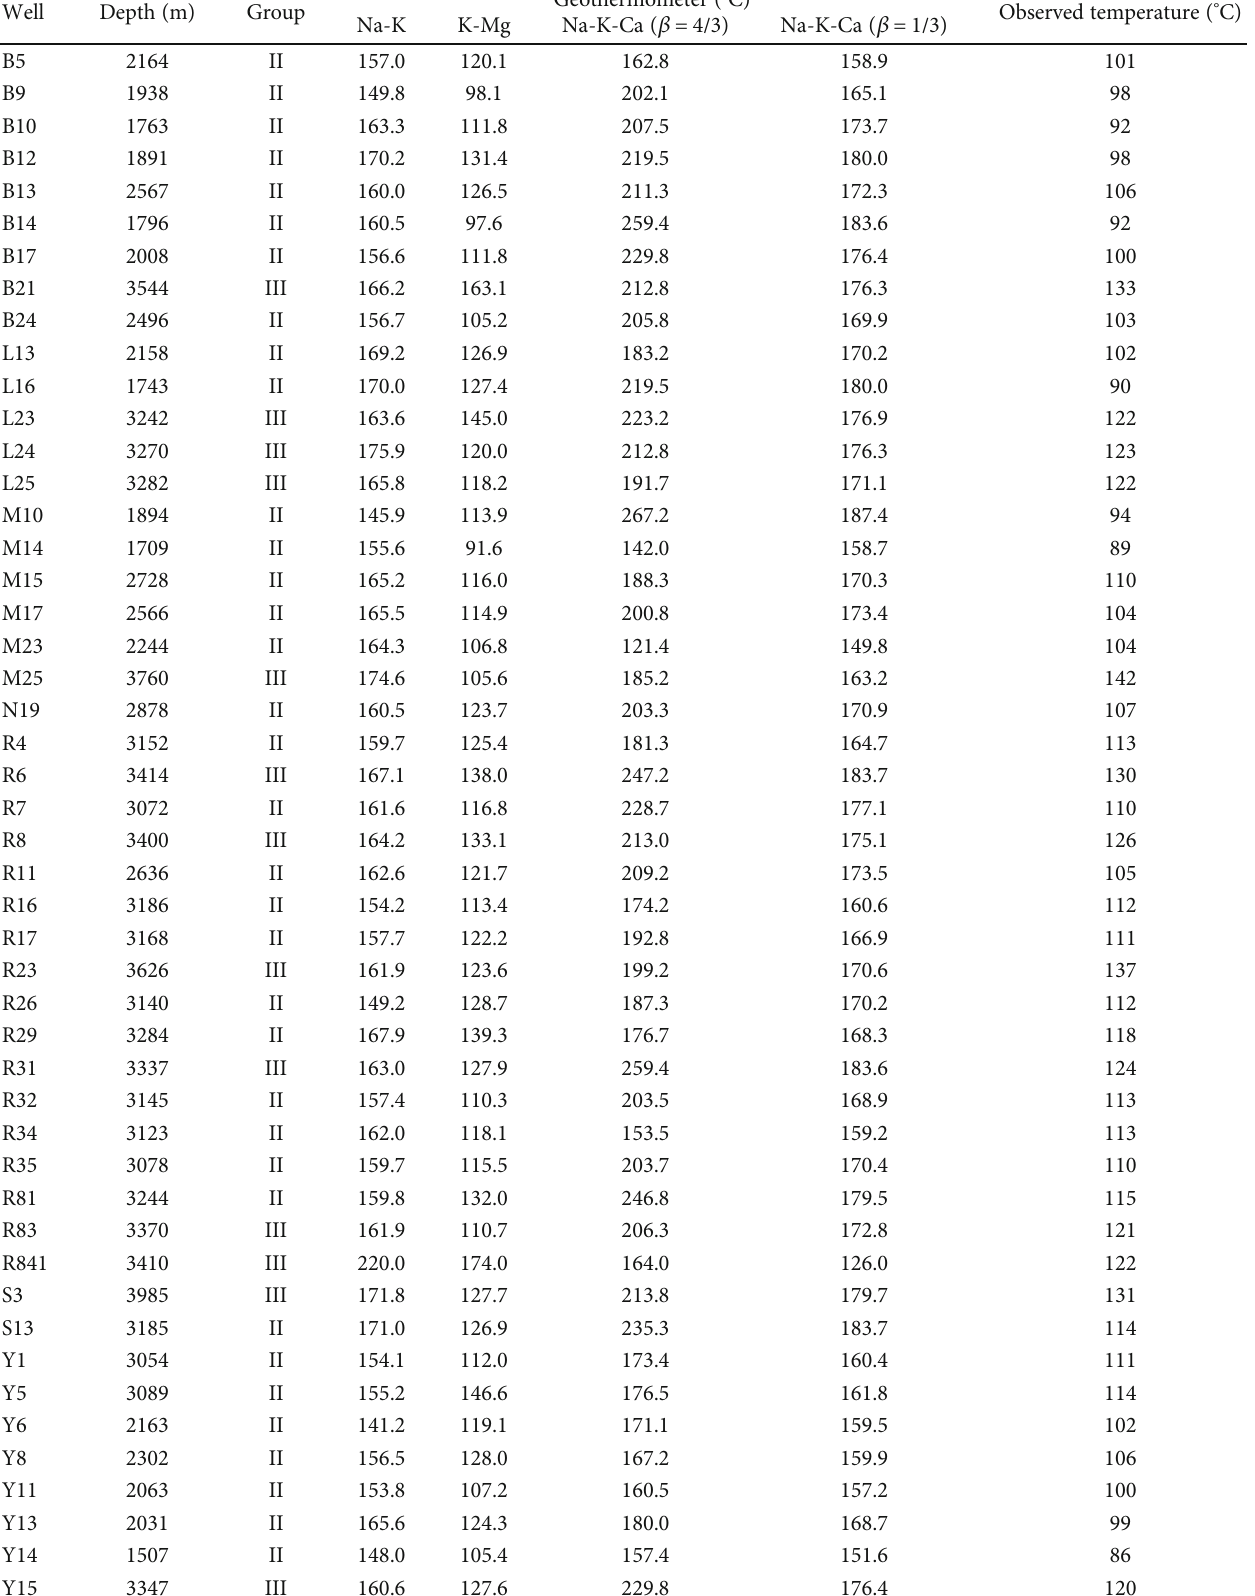
Table 3: Observed temperature and the calculation results of geothermal